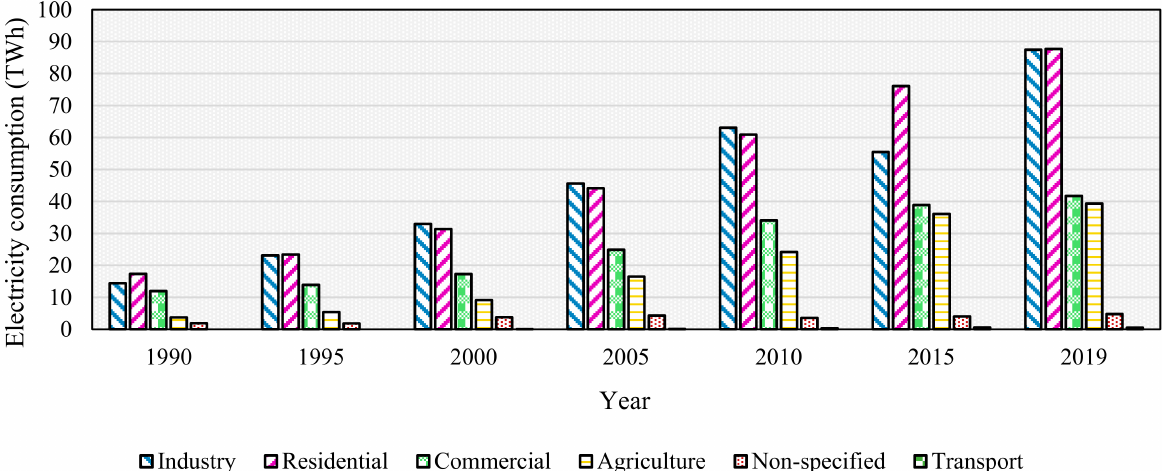
Figure 15. Electricity consumption by different sectors in